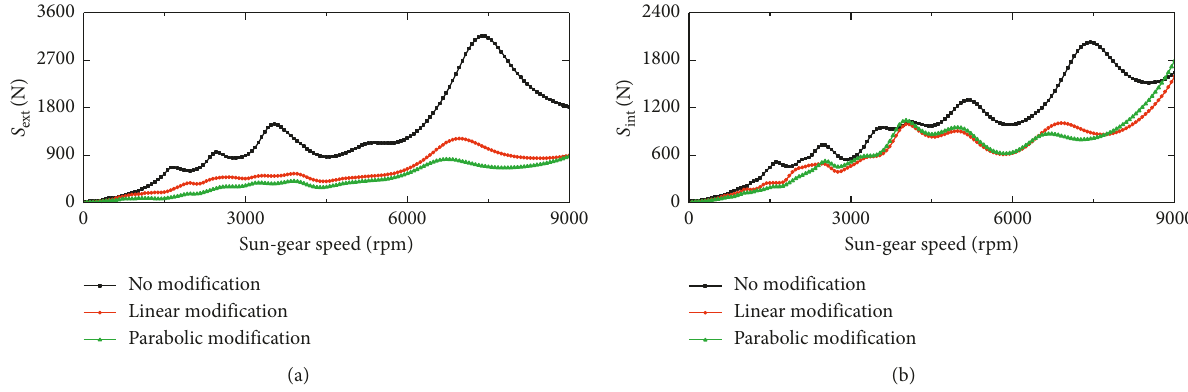
Figure 15: Dynamic tooth loads on external and internal meshes versus sun-gear speed influence of the modification curve: (a) sun-planet meshes and (b) ring-planet